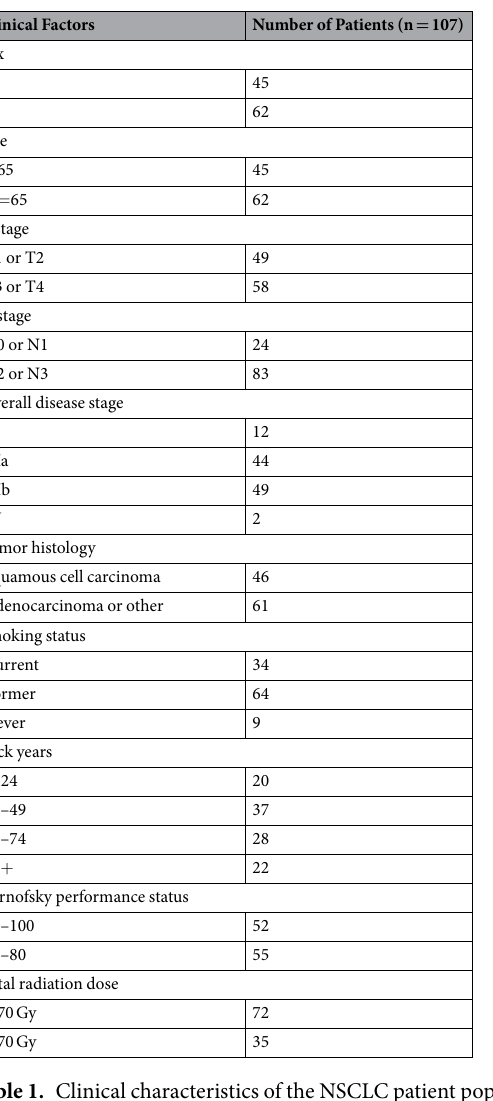
Table 1. Clinical characteristics of the NSCLC patient population used for modeling in this